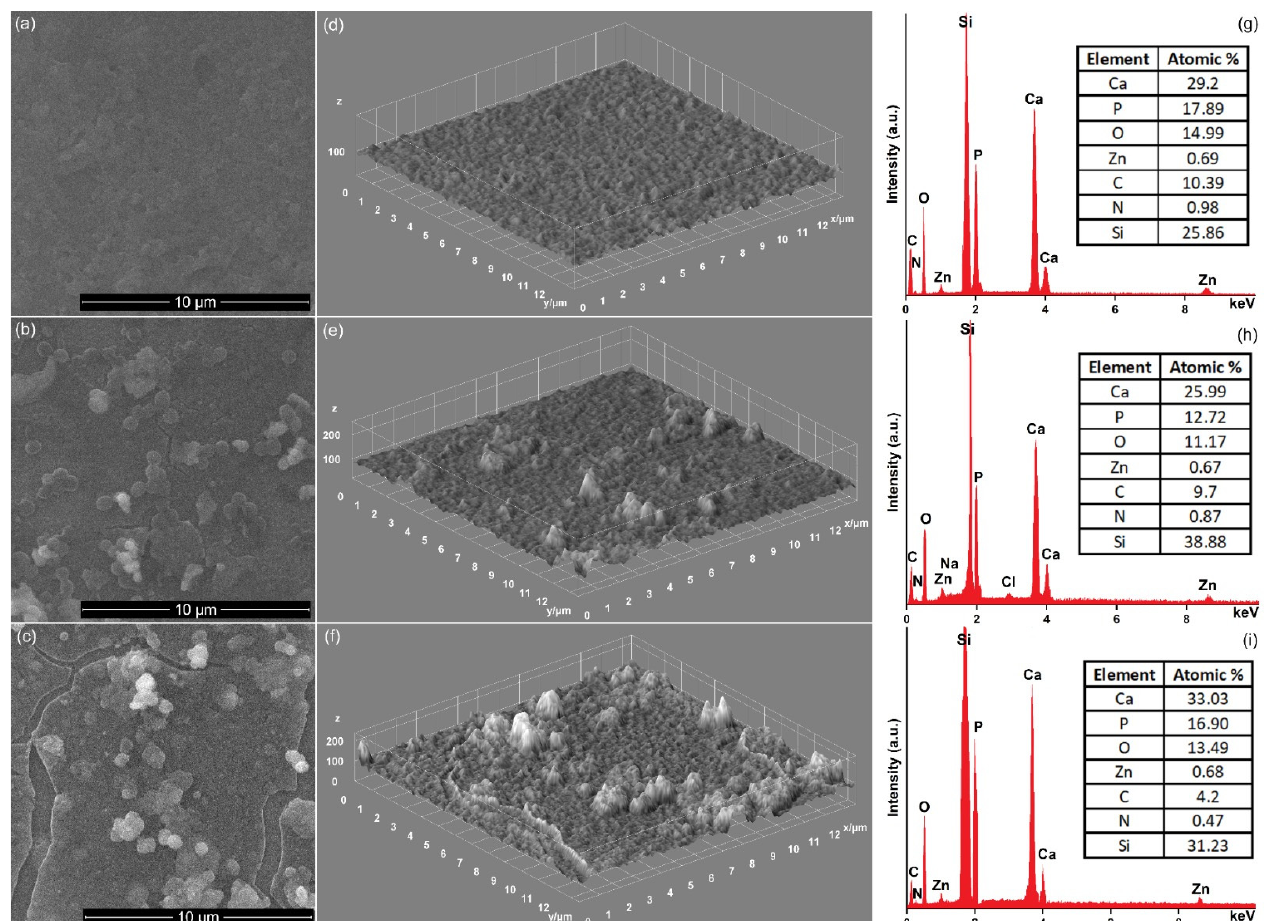
Figure 3. Scanning electron microscopy micrographs (2D and 3D representations) of ZnHApC ( a and d ), ZnHApC-7D ( b and e ), and ZnHApC-14D( c and f ) coatings and their 3D representations. The energy dispersive X-ray analysis (EDX) spectrum of ZnHApC ( g ), ZnHApC-7D ( h ), and ZnHApC-14D ( i ) coatings.